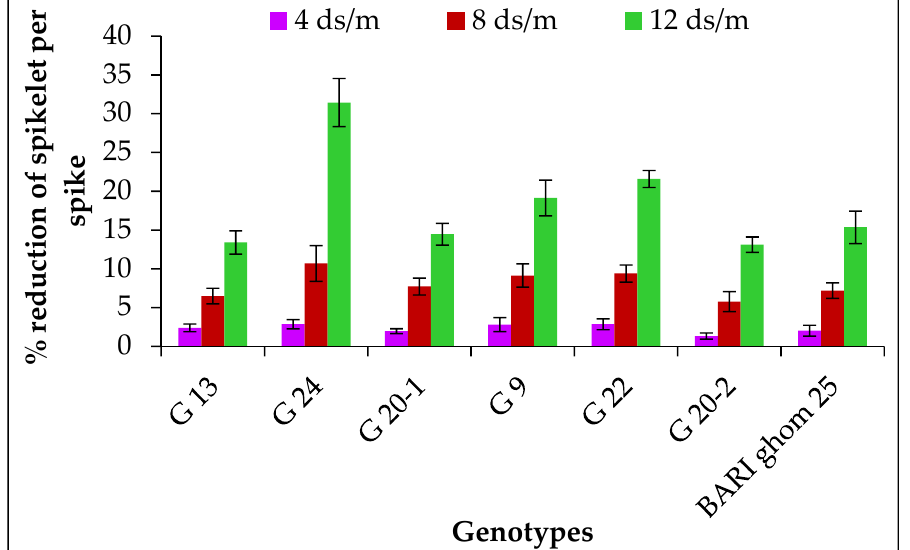
Figure 5. Reduction (%) of spikelets per spike of wheat genotypes under various salinity levels. The vertical bar indicates average of five independent replicates ( n = 5). Error bars represent standard error.